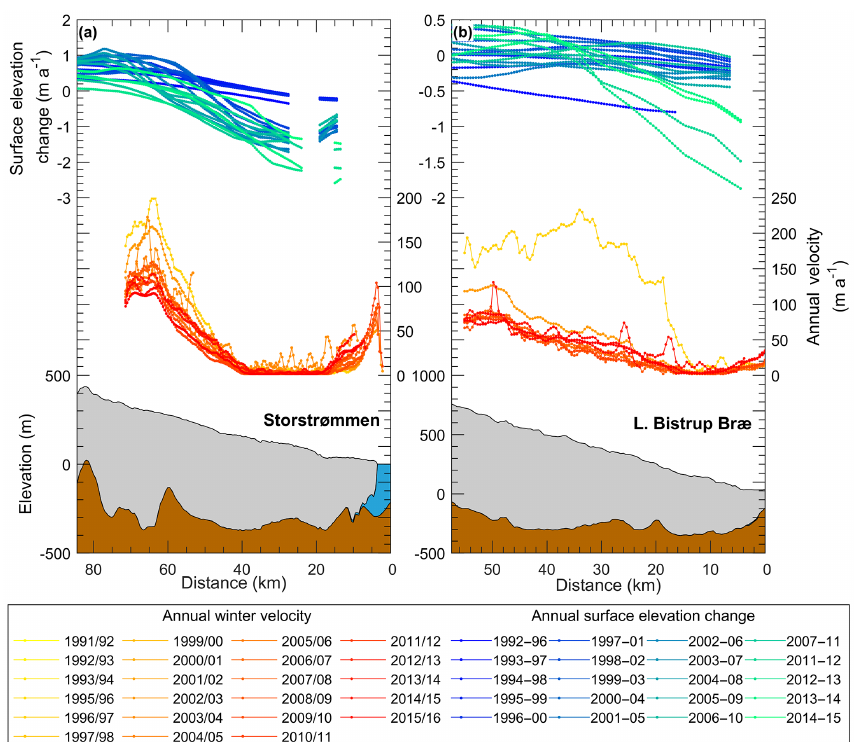
Figure 8. Annual surface elevation change, annual velocity, and surface/bed topography for two outlet glaciers in northeast Greenland: Storstrømmen (a) and L. Bistrup Bræ (b) . Blue to green coloured lines represent annual surface elevation through time (1992–1996